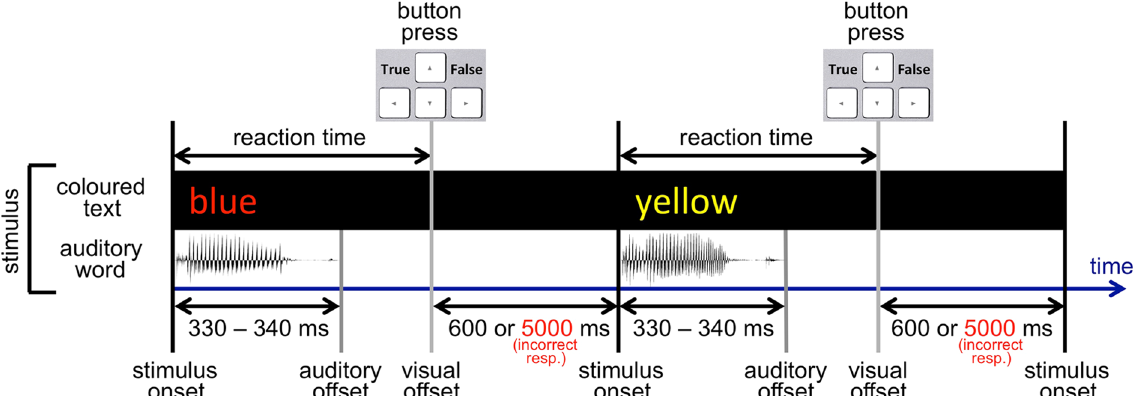
Figure 8. Experimental setup. A stimulus is a coloured text appearing on a monitor simultaneously with an auditory word through a headset. In a reaction-time task, subjects had to categorize each stimulus by pressing Arrow Left (True) or Arrow Right (False) on a keyboard according to a given categorization rule in each block. Please note, that the figure represents the first half of trials of each block, in the second half of trials of each block, the disappearance of the visual part of the stimulus (visual offset) occurred after a short delay of 150 ms after a button-press event (in the case of a correct